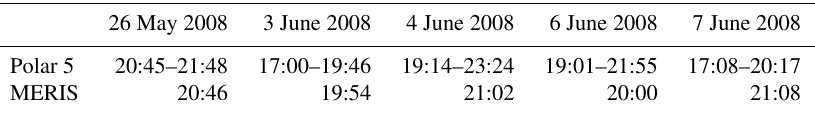
Table 3. Times of airborne measurements (Polar 5) and satellite overflights (MERIS on ENVISAT) in UTC for selected days during the MELTEX campaign in